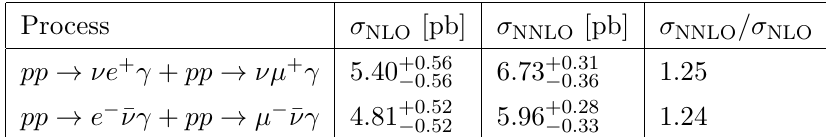
Table 9 . Theoretical predictions for described in the text. The ratio σ corrections are still substantial at